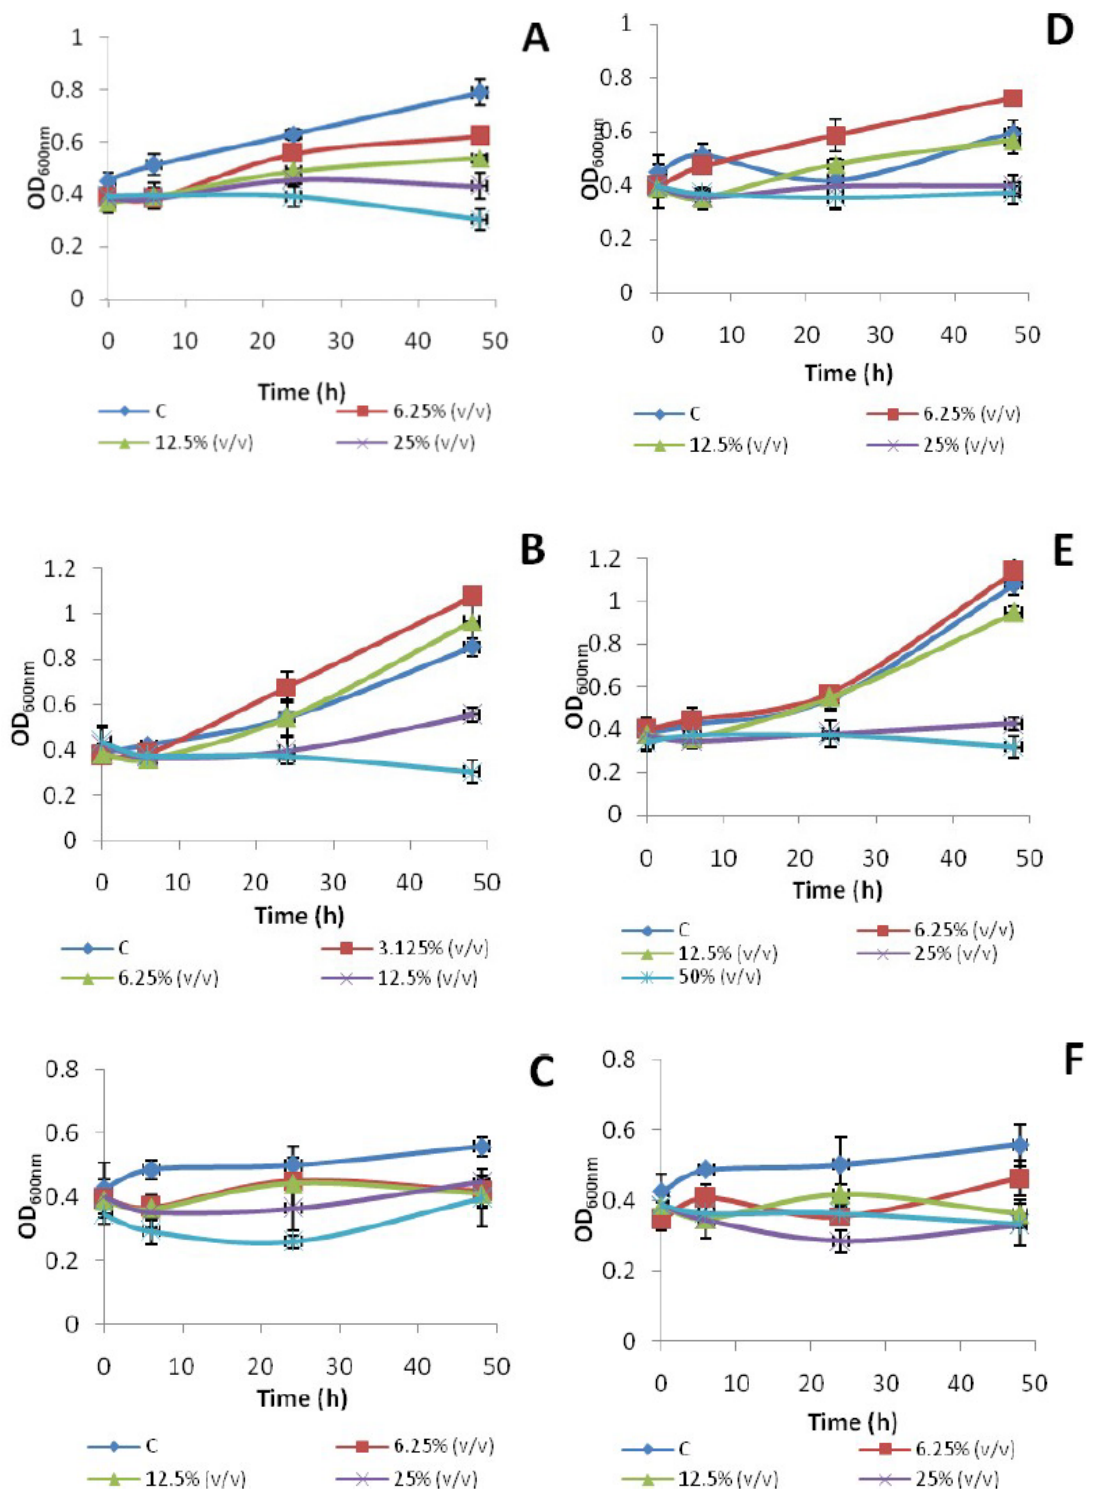
Figure 1. Effect of different concentrations of branded honey (Marhaba) ( A – C ) and unbranded honey (extracted from Ziziphus mauritiana plant) ( D – F ) on bacterial growth (OD 600nm ) of E. coli ATCC 10536 ( A , D ), S. Typhi ( B , E ) and K. pneumoniae ( C , F ). Antimicrobial activity of honeys related to coniferous, thyme and polyfloral origin against certain pathogenic microorganisms was highlighted by Olaitan and Voidarou [4,13]. The MIC of Ulmo